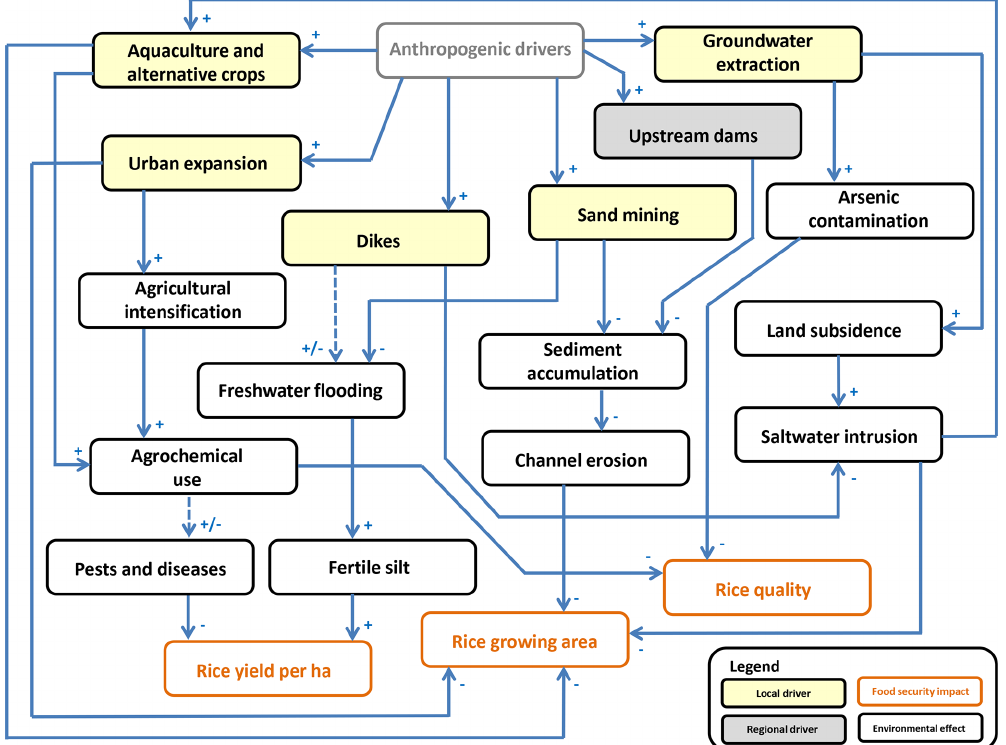
Figure 4. Flow diagram showing the key anthropogenic drivers that affect rice production in the two mega-deltas of Vietnam. The drivers are classified as a local driver if it occurs in the two mega-deltas. Regional drivers are those that occur farther away from the two mega-deltas but within the Asian region. A plus ( + ) sign indicates that an increase (decrease) in A causes B to increase (decrease). A negative ( − ) sign indicates that an increase (decrease) in A causes B to decrease (increase). Dashed lines with “ ± ” are used when outcomes are unclear. For example, dikes reduce flooding, but poorly maintained or planned dikes increase flooding instead. In addition, dikes may potentially cause flooding in unprotected areas. Agrochemical use may reduce the incidence of pests and diseases, but the overuse of chemicals can lead to pesticide resistance, which may increase outbreaks of pests and